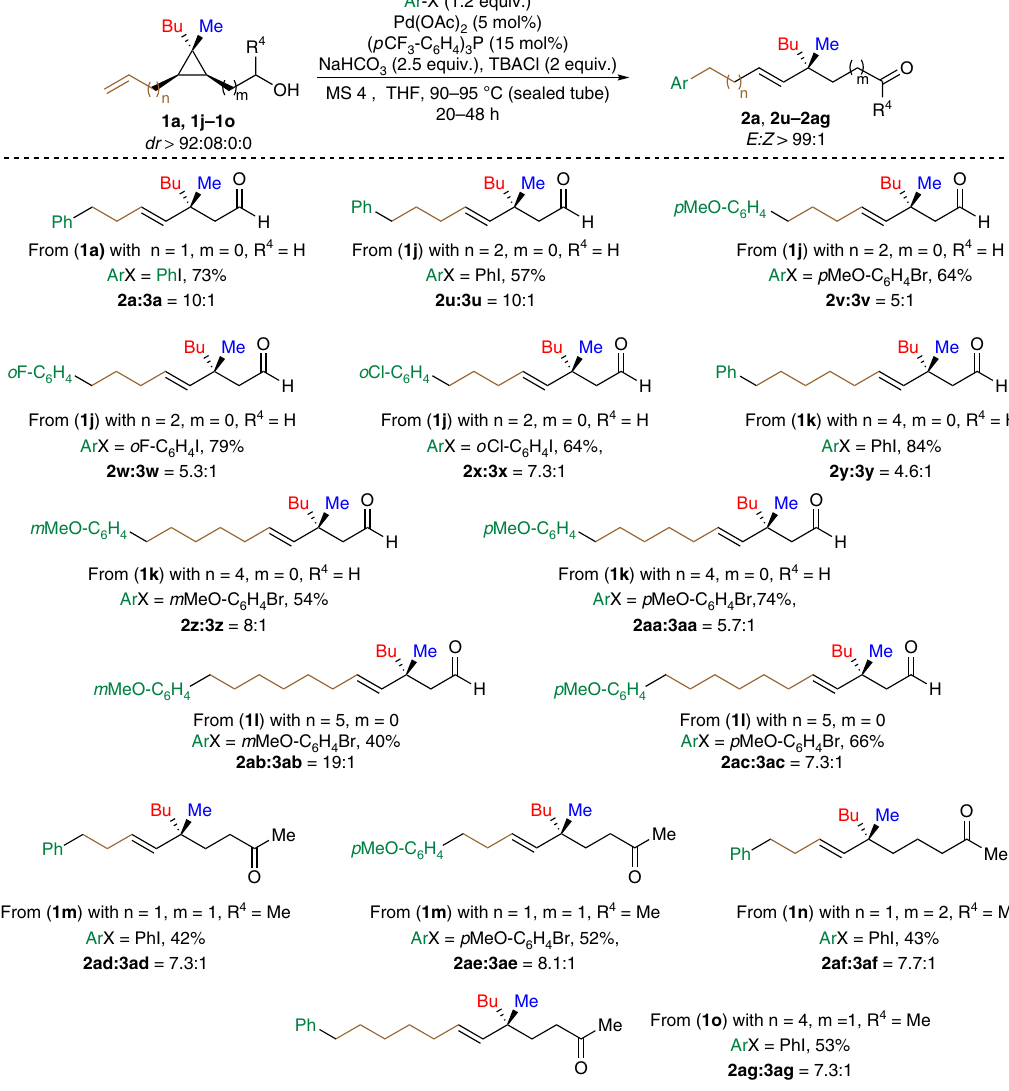
Figure 4 | Scope of the chain lengths ( n and m ). Increase of the molecular distance ( n ) between the double bond and cyclopropane moieties as well as the molecular distance ( m ) between the alcohol and cyclopropane and finally the situation where both chain length n and m are